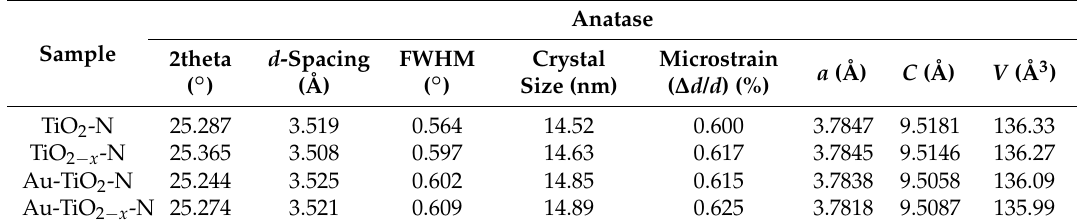
Figure 4. X-ray Diffraction (XRD) patterns of various TiO 2 supports and Au-TiO 2 catalysts. Table 1. Microstructure parameters of various TiO 2 supports and Au ‐ TiO 2 catalysts.